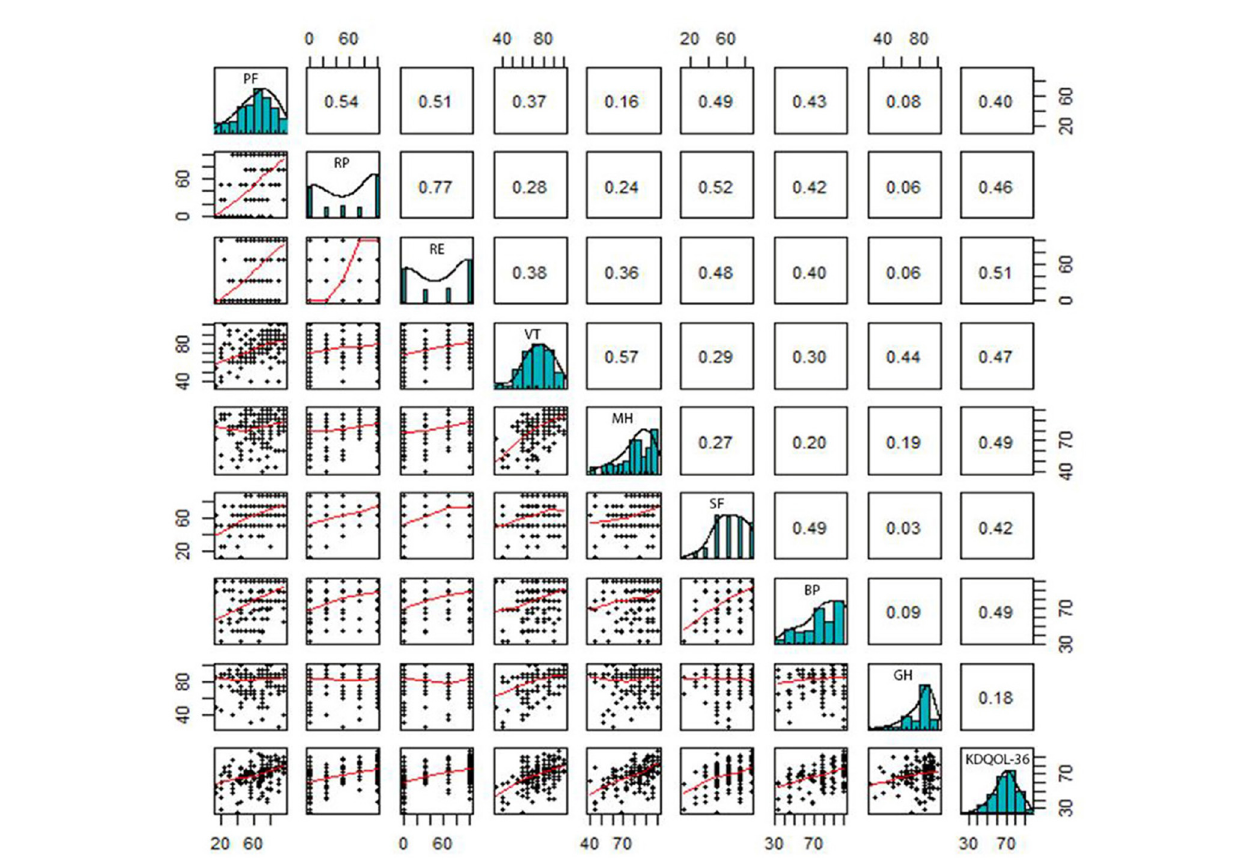
FIGURE 3 | Correlation between the domains measured by KDQOL-36 and SF-36. PF, Physical Functioning; RP, Limitations in Daily Role Functioning due to Physical Problems; BP, Bodily Pain; GH, General Health; VT, Vitality; SF, Social Functioning; RE, Limitations in Daily Role Functioning due to Emotional Problems; MH, Mental